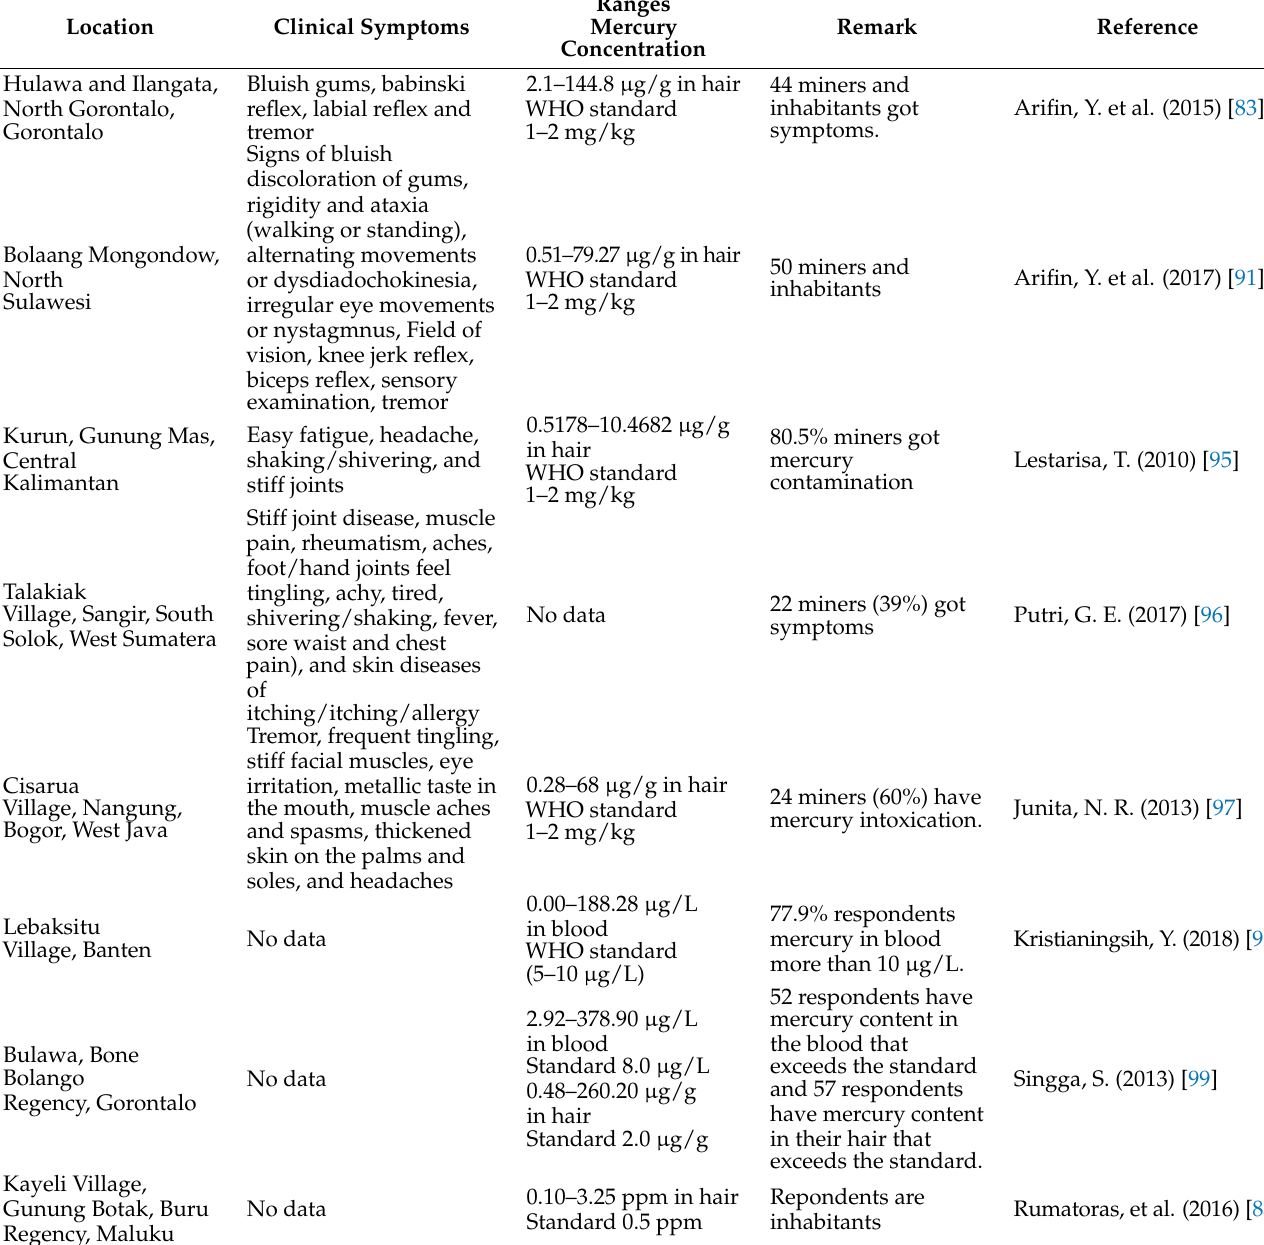
Table 6. Mercury intoxication and its effects on